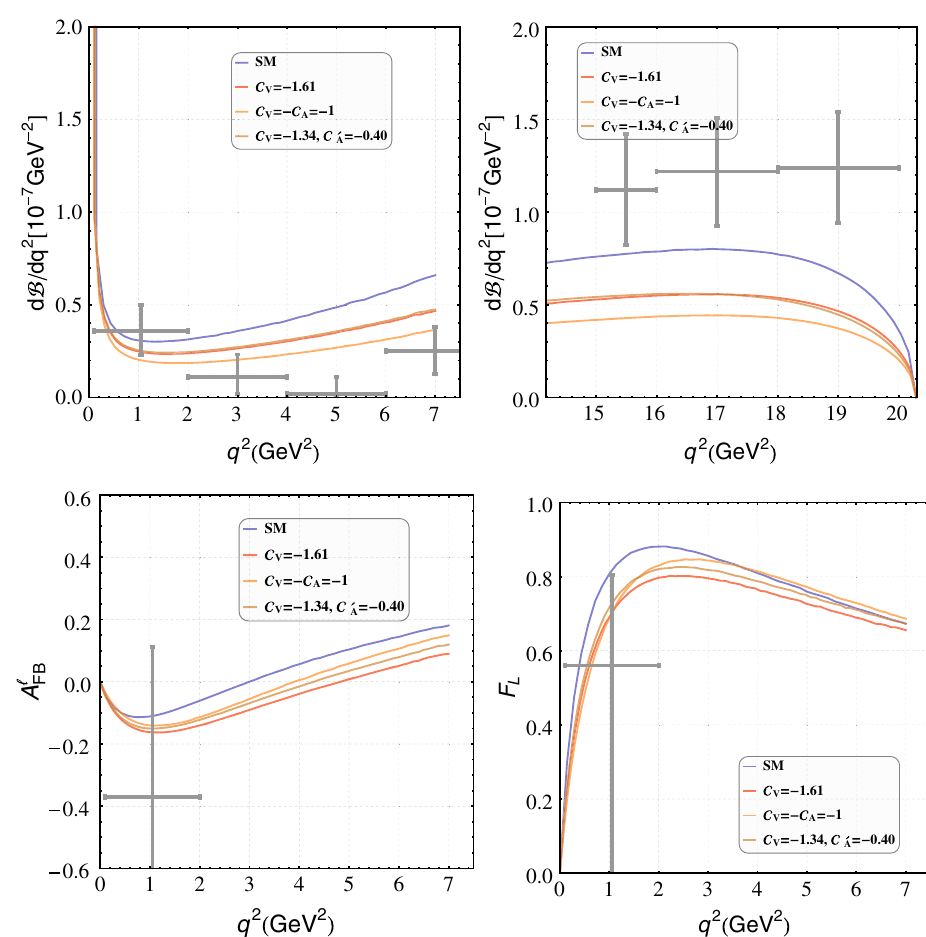
Fig. 2 The (cid:2) b → (cid:2)μ + μ − observables in the SM (blue) and for representative sets of new VA couplings (shades of red). The points shown by cross marks indicate LHCb data [22]